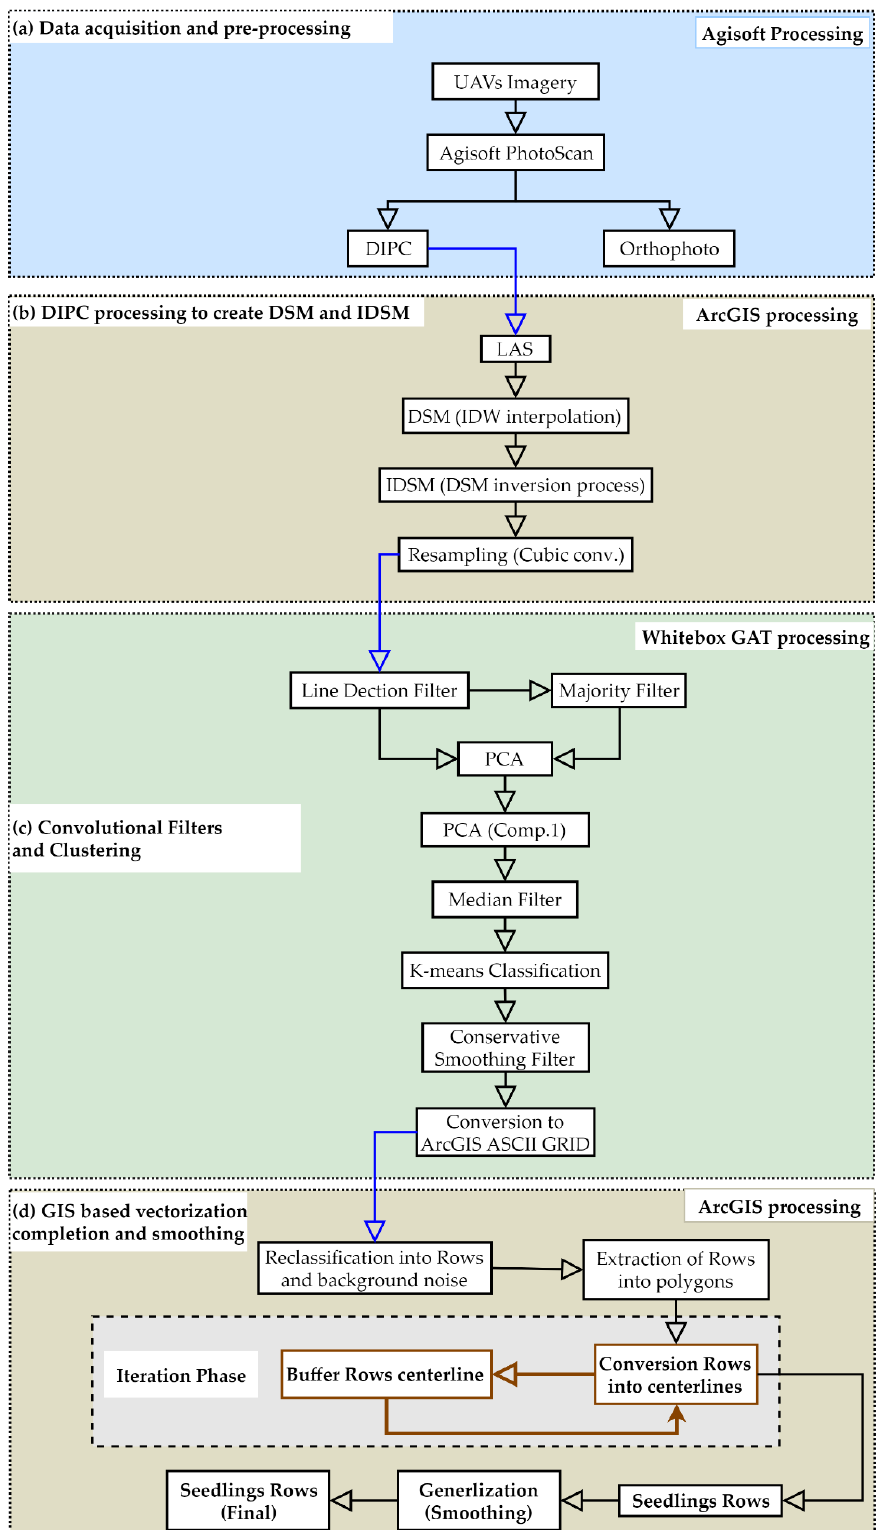
Figure 6. UAV data processing workflow: (a) UAV data processing to obtain DIPC and Orthomosaic (Figure 3); ( b ) raw-DIPC processing to create DSM and IDSM; ( c ) convolutional filtering, image transformation, unsupervised clustering; (d) GIS-based vectorization and processing to obtain plantation rows.